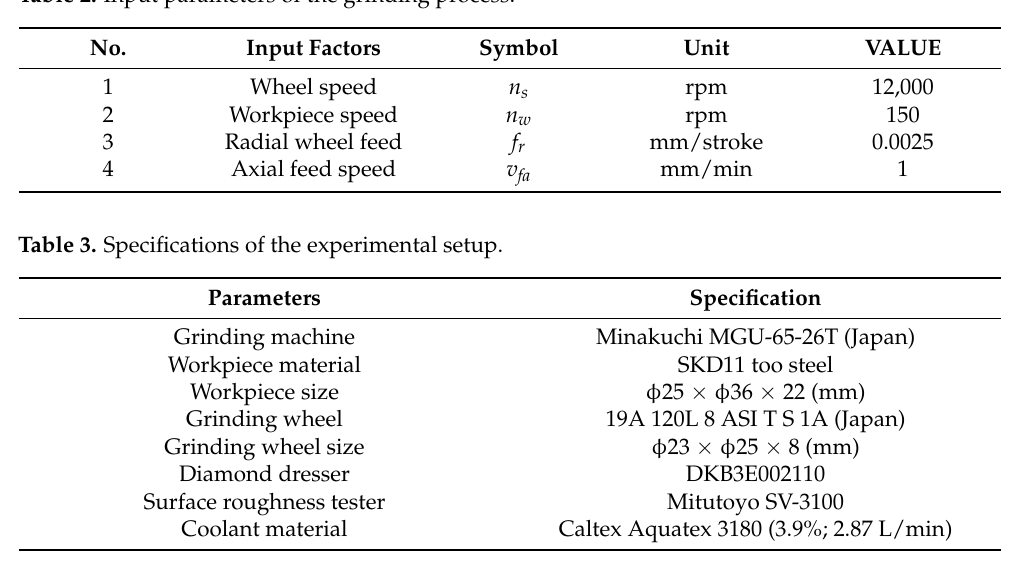
Table 4. Experimental plan and output results.